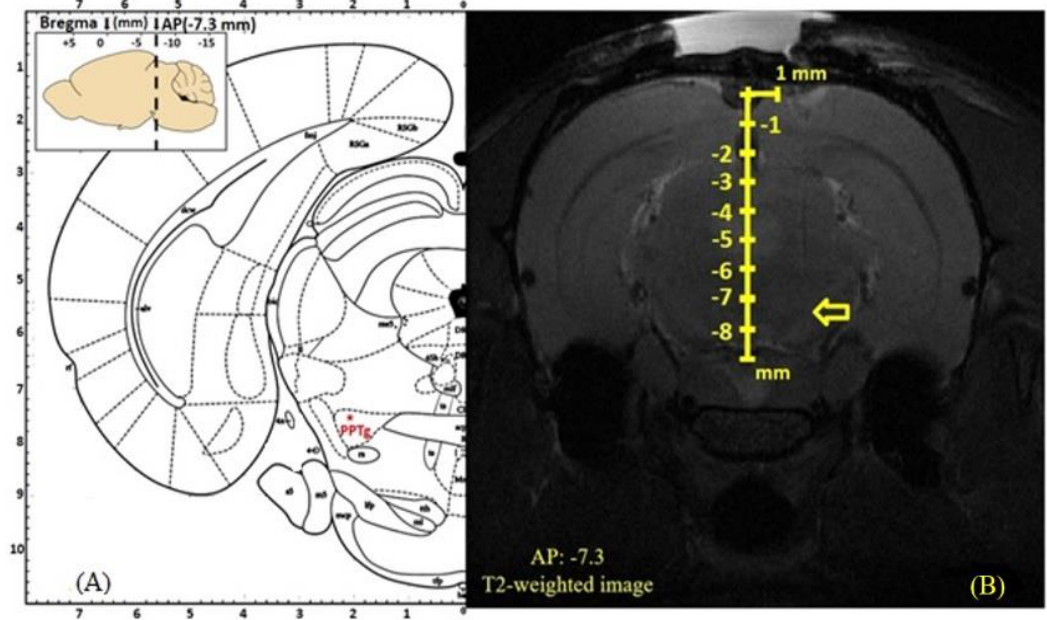
Figure 1. ( A ): The left part shows the schematic representation of the ventral PPTg in an atlas, the red asterisk indicates the ventral point of PPTg (AP 7.3 mm, L +2.0 mm, DV 7.5 mm). ( B ): The MRI results with the tip of a DBS electrode located exactly at the ventral point of PPTg, as indicated by the yellow arrow.